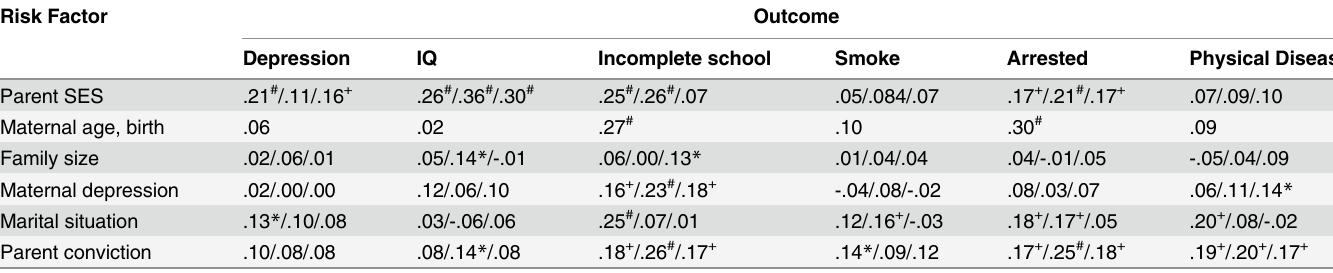
Table 3. Partial Intercorrelations between Risk and Outcome